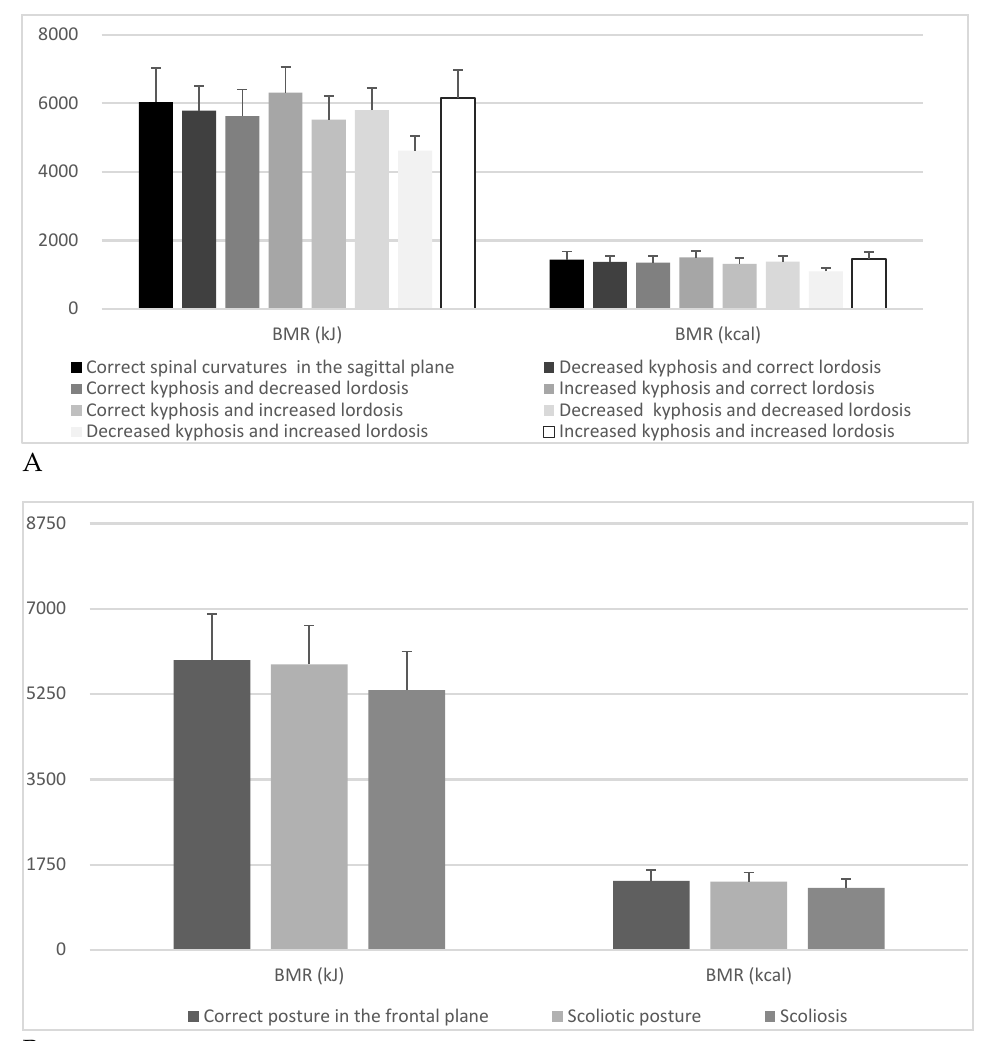
Figure 4. Basal metabolic rate and: sagittal spine types ( A ) and correct posture in the frontal plane, scoliotic posture and scoliosis ( B ).